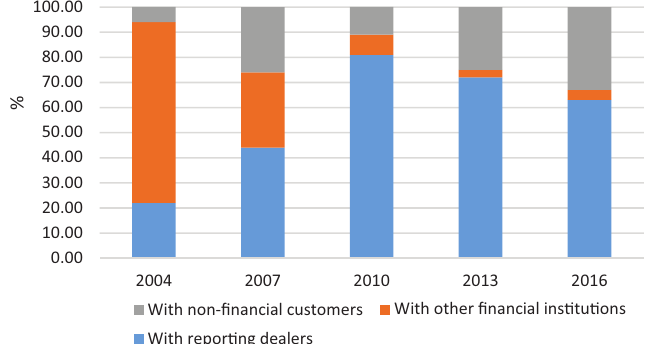
Figure 5. Total turnover by foreign exchange market participants in Lithuania in 2004–2016, in % (source: developed by the authors based on LB, 2016, 2018, 2019b; BIS, 2018b)